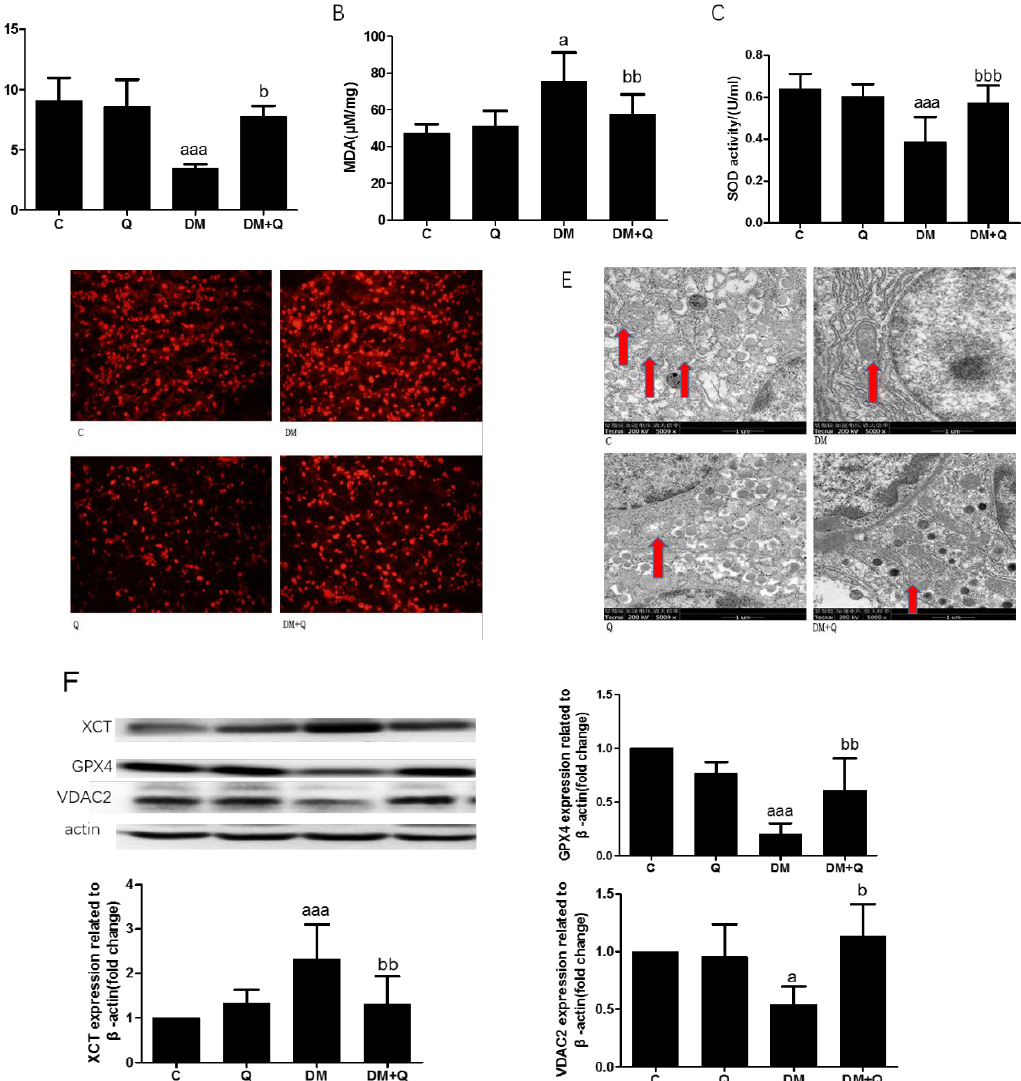
Figure 5. E ff ect of quercetin on improving the phenotype of ferroptosis. ( A ). Glutathione (GSH) content was measured using the homogenates of the pancreas in the light of instructions of reagent kits ( n = 10); ( B ). Malondialdehyde(MDA) level was measured using the homogenates of the pancreas according to reagent kits ( n = 10); ( C ). Superoxide dismutase (SOD) activity was measured using the homogenates of the pancreas according to the manufacturer’s instructions ( n = 10); ( D ). Reactive oxygen species (ROS) level was determined by Dihydroethidium (DHE) probe; ( E ). Mitochondria (red arrows indicated) were observed from transmission electron microscope (TEM) images (5000 × ) showing representative mitochondria structure of β cells; ( F ). Western blot analysis was performed to measure xCT, GPX4, and VAC2 and quantified by Image-Pro Plus 6.0 software. Blotting with β -actin was used as a protein loading control. Data were expressed as mean ± SD (a: p < 0.05 vs. C; aaa: p < 0.001 vs. C; b: p < 0.05 vs. DM bb: p < 0.01 vs. DM; bbb: p < 0.001 vs. DM).